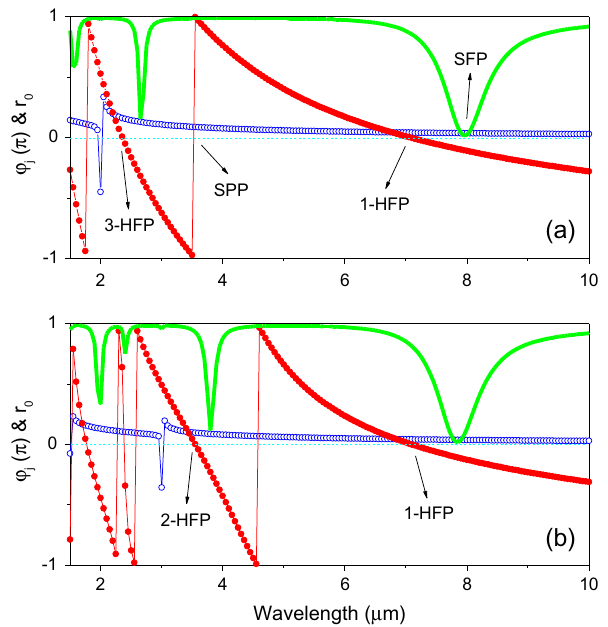
Figure 11. Incident-angle dependence of phase shift and reflection spectrum: (a) h = 0 o and (b) h = 30 (cid:3) . Here, u 1 , u 3 , and r 0 are labeled by the open circles, solid circles, and the line, respectively. As an example, the structure parameters are set as d = 2000 nm, a = 50 nm, h = 100 nm, and t = 20 nm.